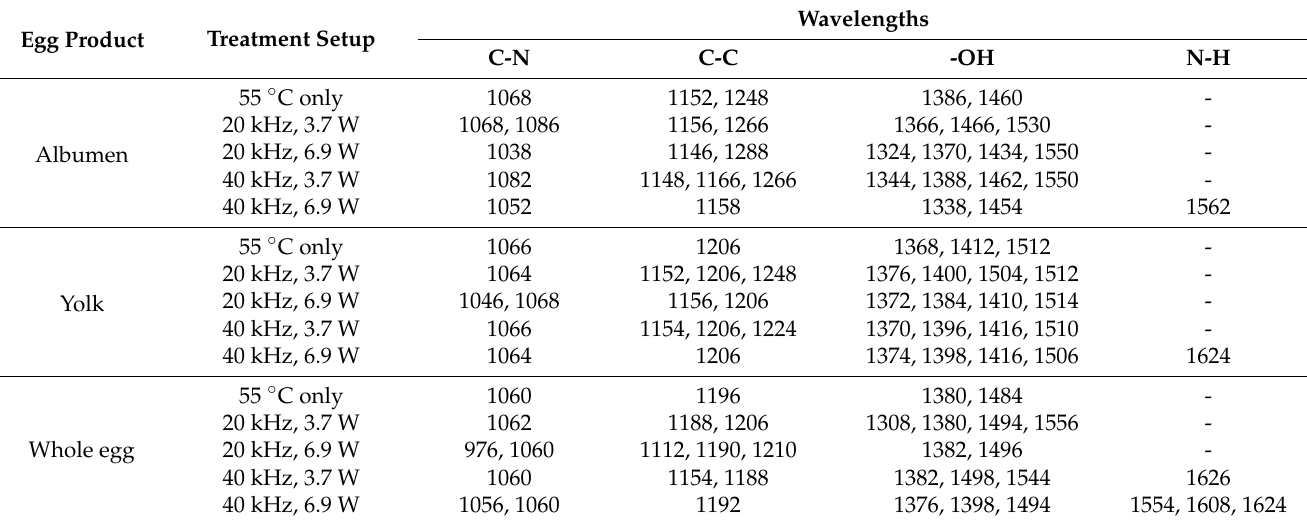
Table 3. Contributing wavelengths of the PCA